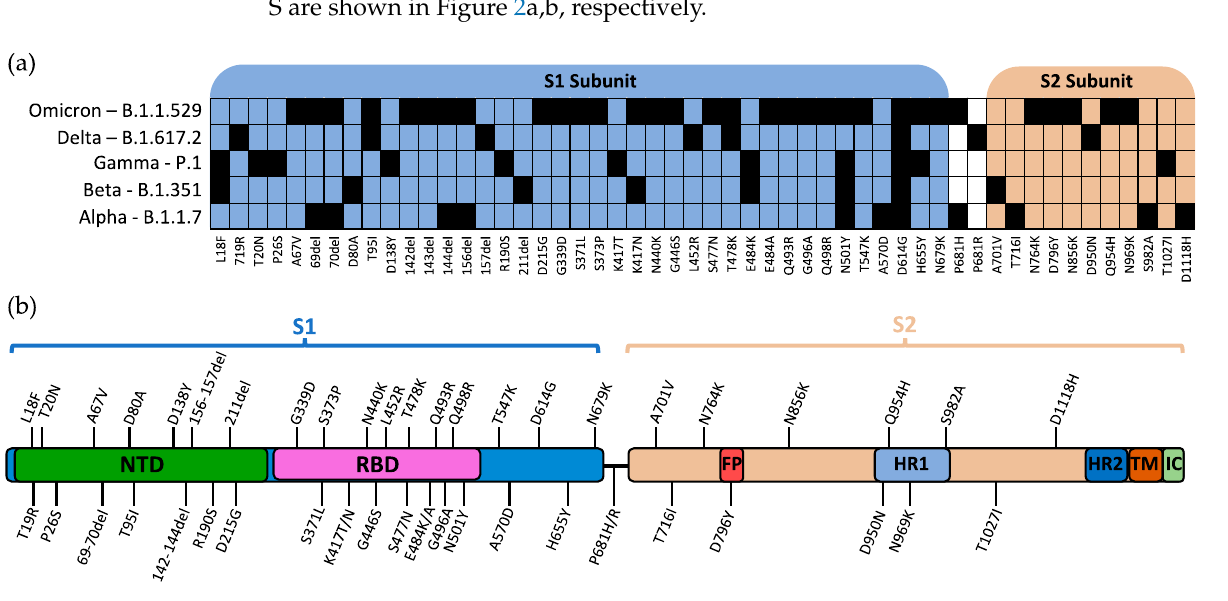
Figure 2. Mutations of spike protein within VOCs. ( a ) Defining mutations of WHO-labelled VOCs and their relative position in the S1/S2 subunits. ( b ) Visual representation of the relative position of mutations within the SARS-CoV-2 spike protein. Mutations are reported as listed in the CoV-Lineages database as of December 2021. NTD: N-terminal domain; RBD: receptor-binding domain; FP: fusion peptide; HR1: heptad repeat 1; HR2: heptad repeat 2; TM: transmembrane region; IC: intracellular domain.